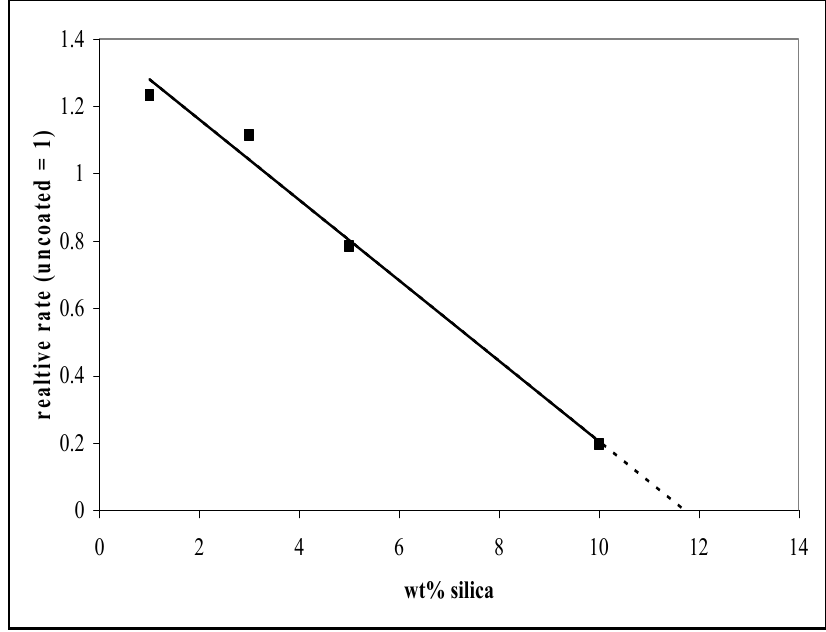
Figure 7. ( A) Decrease in relative rates of propan-2-ol oxidation at high levels of silica deposited on rutile #2. (The activity of rutile 2 is taken as 1.0.); ( B ) Changes in the relative rates of propan-2-ol oxidation for rutile #2 coated with increasing amounts of alumina (—), has a rate of 1 and all other rates are and silica (---). In both cases, the uncoated TiO 2 relative to